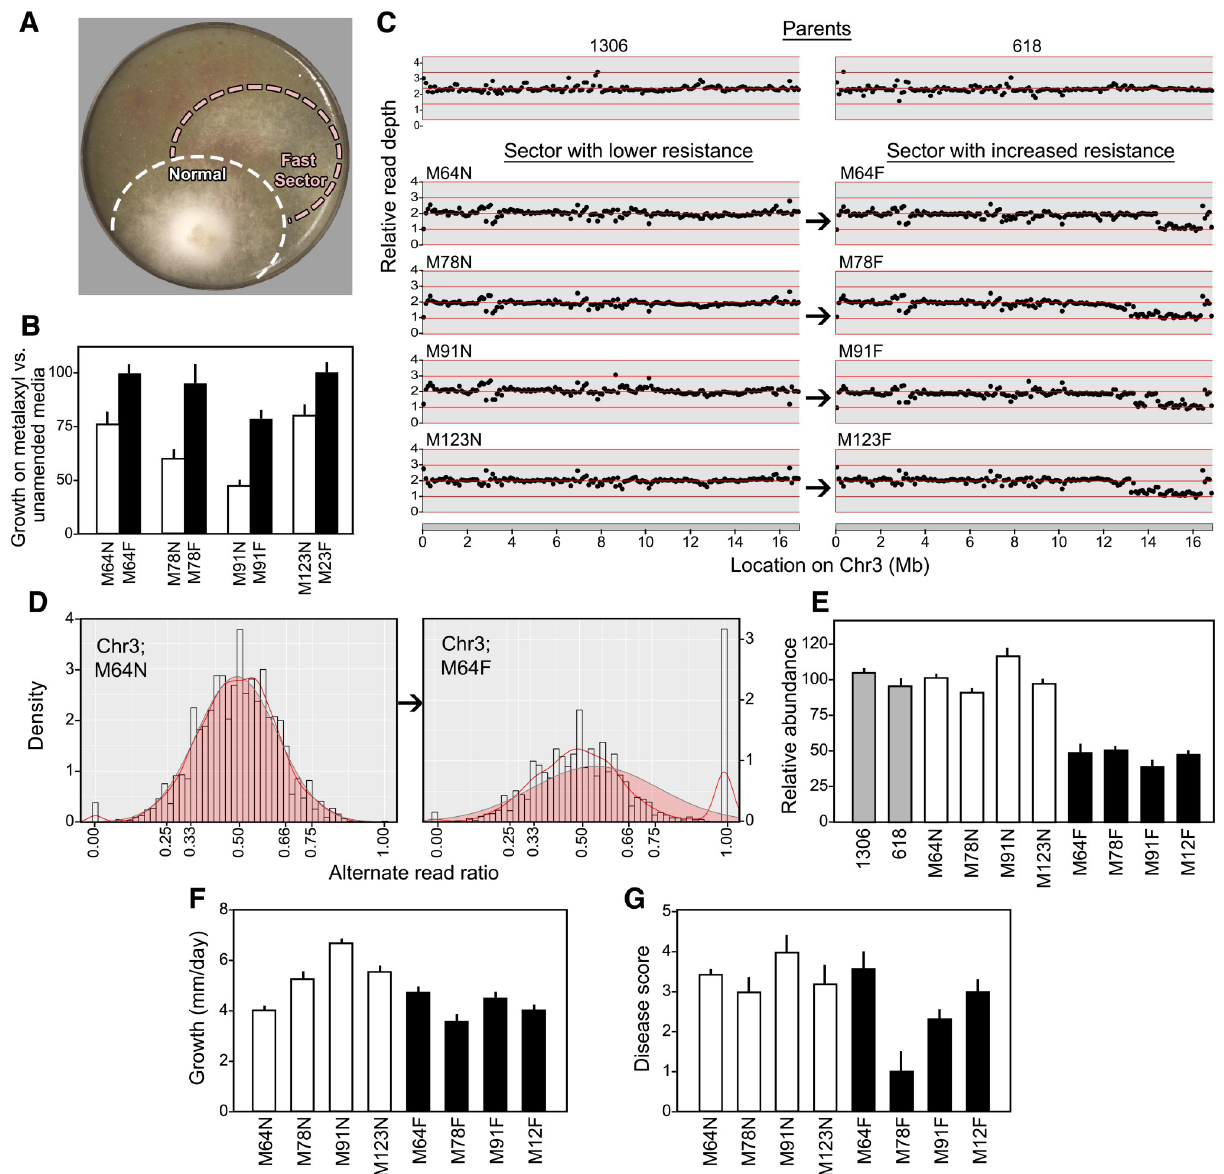
Fig 10. Changes induced by growth on metalaxyl. A , fast-growing sector emerging from a representative Mex/mex F1. B , relative growth rates of normal (N) and faster-growing (F) sectors from progeny M64, M79, M91, and M123. C , read depth along Chr3 in parents 1306, 618, and normal and fast sectors, revealing reduced copy number on the right arm of Chr3 in the fast variants. D , variant ratios of heterozygous SNPs along Chr3 in normal progeny M64N and its fast-growing derivative, M64F. The pileup of about 12% of markers at 1.00 reflects the loss of heterozygosity. E , confirmation of deletions in Chr3 using qPCR. Values indicate the ratios of the calculated concentration of the deleted region and the non-deleted region in DNA from normal progeny sectors (white), fast-growing sectors from the same progeny (black), and the parents (grey).